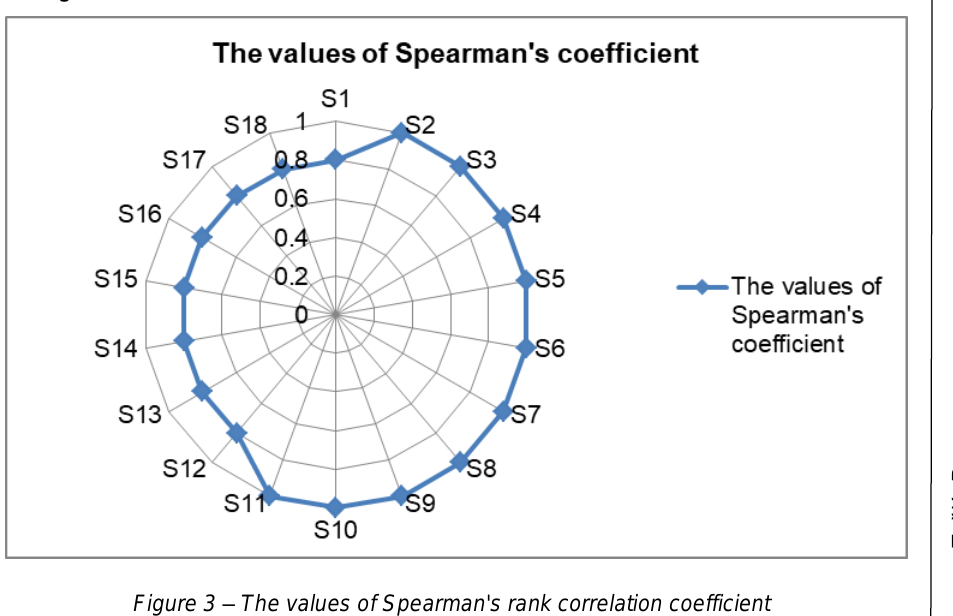
Figure 3 – The values of Spearman's rank correlation coefficient Рис. 3 – Значение коэффициента ранговой корреляции Спирмена Слика 3 – Вредности Спирмановог коефицијента корелације